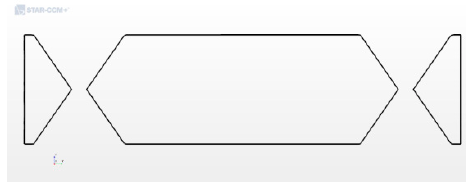
Figure 2. Cross-section of the heave plate.